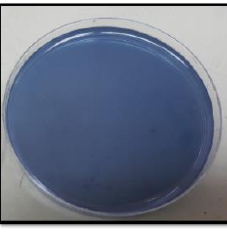
Figure 3: Mitis- Salivarius Bacitracin Agar Blood